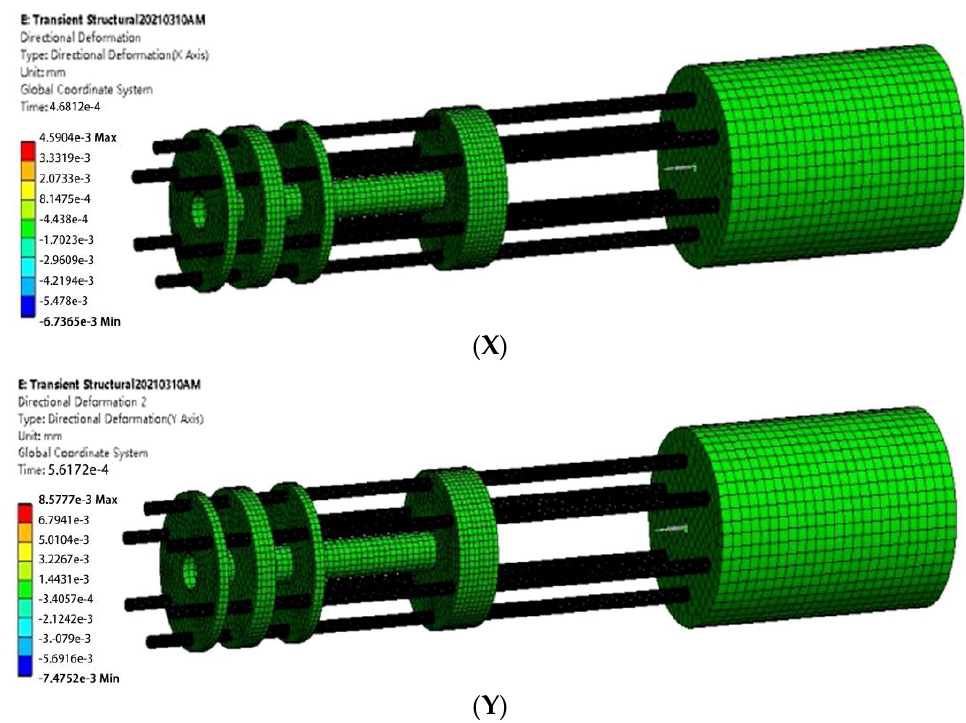
Figure 26. X (transverse) and Y (vertical) of the cross-sectional area reduce the effect by 10%. And the maximum of X and Y is shown in Table 6. Table 6. Maximum of X (transverse) and Y (vertical) about Cross-sectional area. Cross-Sectional Area Maximum of Cross-Sectional Area